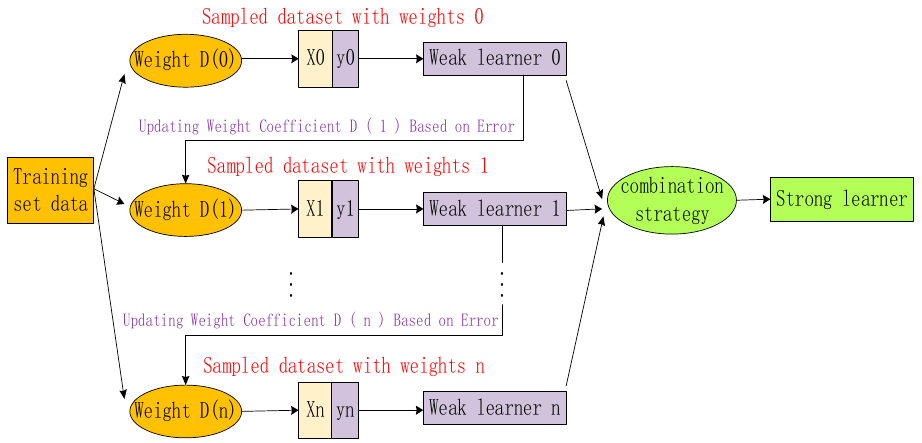
Figure 2. Block diagram of boosting algorithm.